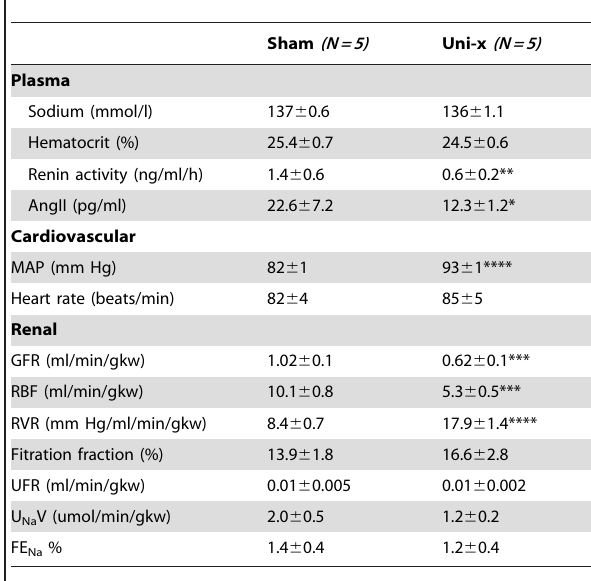
Table 1. Basal plasma electrolyte and hormones and basal cardiovascular and renal parameters in 5 year old sham and uninephrectomised (uni-x)